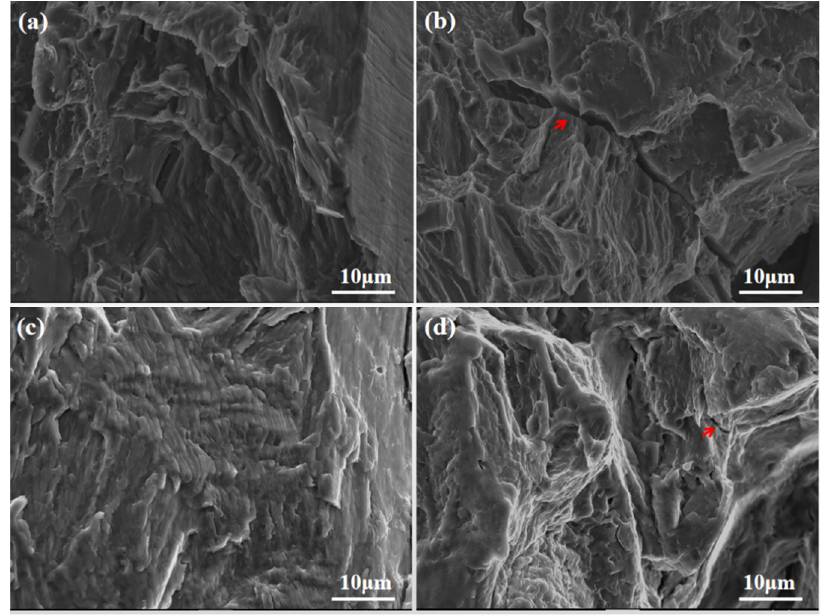
Figure 7. Fatigue fracture morphology of RD: ( a , b ) strain amplitude of 0.5%; ( c , d ) strain amplitude of 1%.